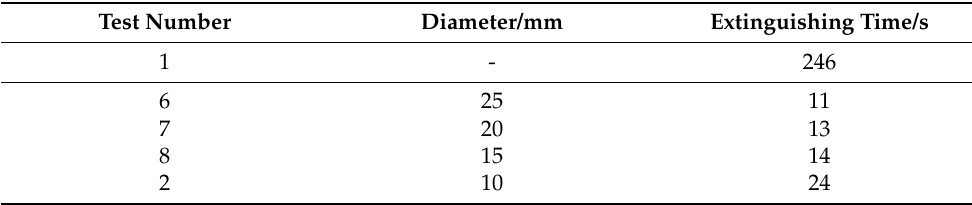
Table 6. Extinguishing time under different test conditions.